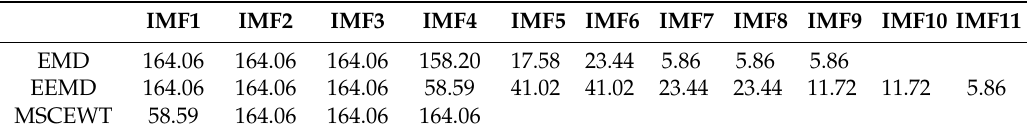
Table 6. The experimental results of inner race of the motor